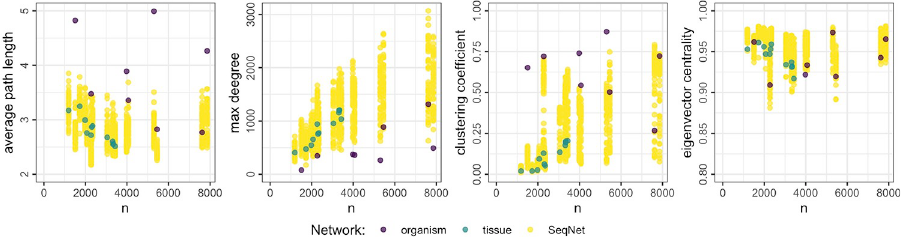
Fig 4. Distribution of four topological measures with respect to network size. The purple and teal dots correspond to the eight organism-specific networks and 12 human tissue-specific networks, respectively. Yellow dots show 50 simulated networks for each network size from the proposed generator. The distribution of generated topologies covers the wide variety found in the reference gold-standard networks.